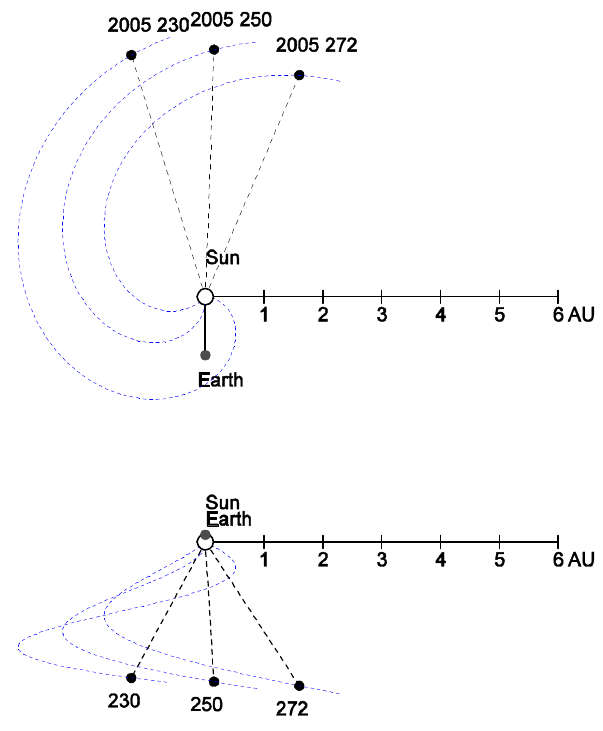
Fig. 3. The position of Ulysses on DOY 230, 250 and 272 of 2005 with respect to the fixed Sun-Earth line, projected (a) on the solar equatorial plane as viewed from the north (top), and (b) on a plane perpendicular to the solar equator as viewed from the Earth toward the Sun (bottom) is shown. Also shown as dashed blue lines are the ideal Archimedes spiral magnetic field lines connecting Ulysses to the solar surface, calculated using the measured solar wind speed.